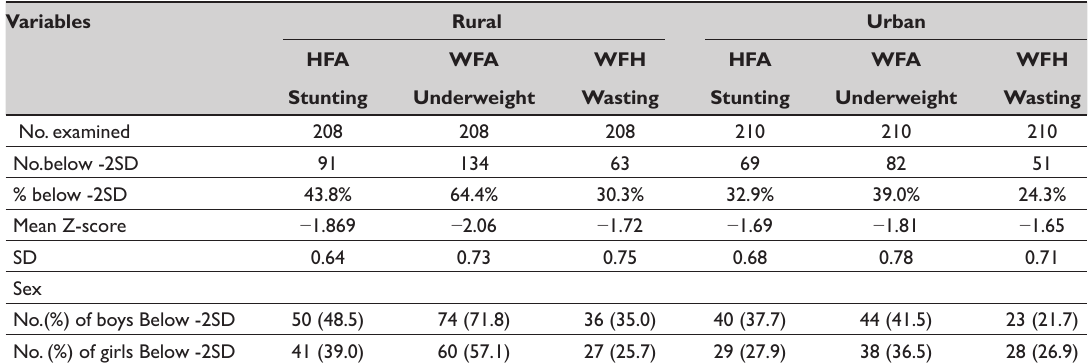
Table 4: Nutritional Status of Rural and Urban Children Variables Rural Urban HFA WFA WFH HFA WFA WFH Stunting Underweight Wasting Stunting Underweight